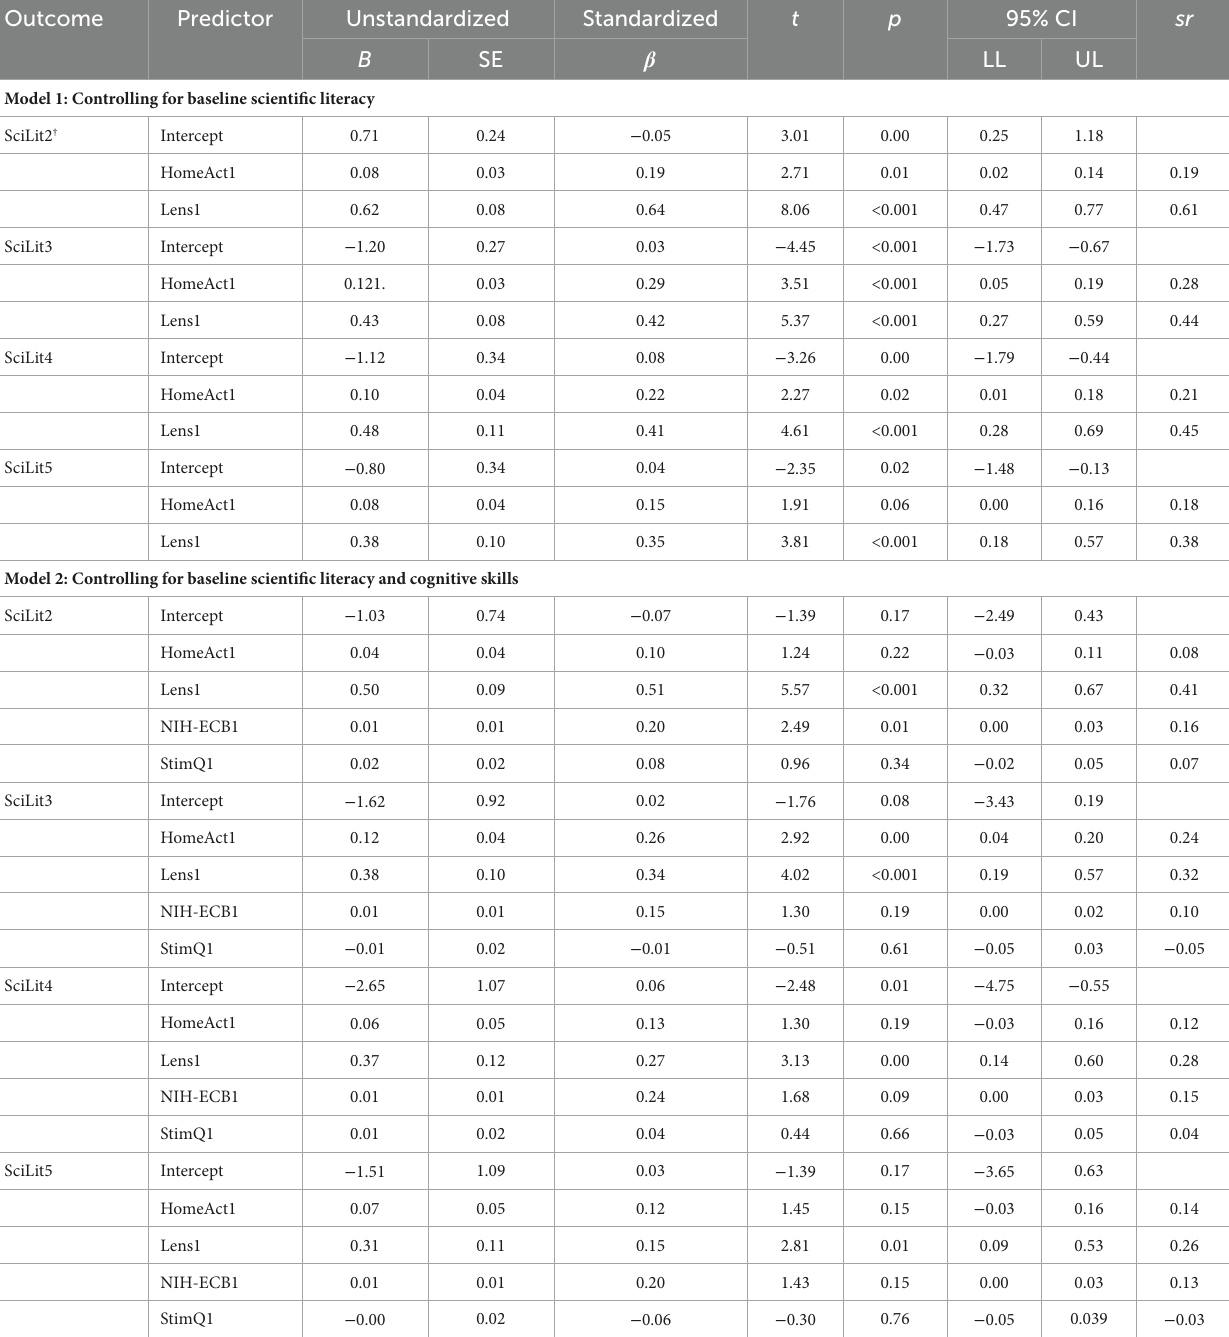
Outcome Predictor